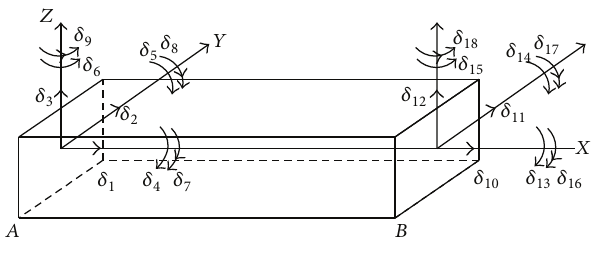
Figure 2: Model of beam